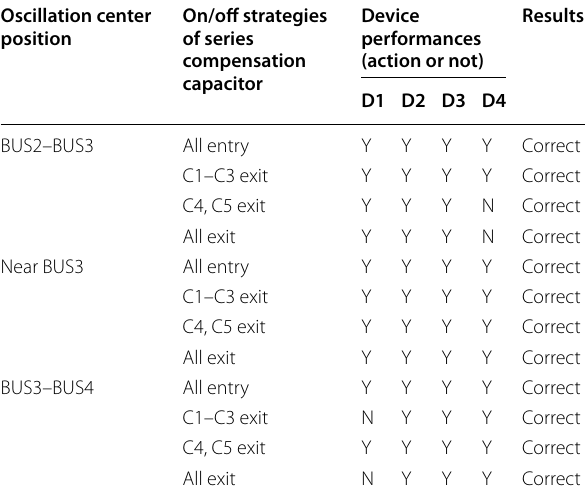
Table 6 Performance of the devices in test scenario 2 Oscillation center On/off strategies position of